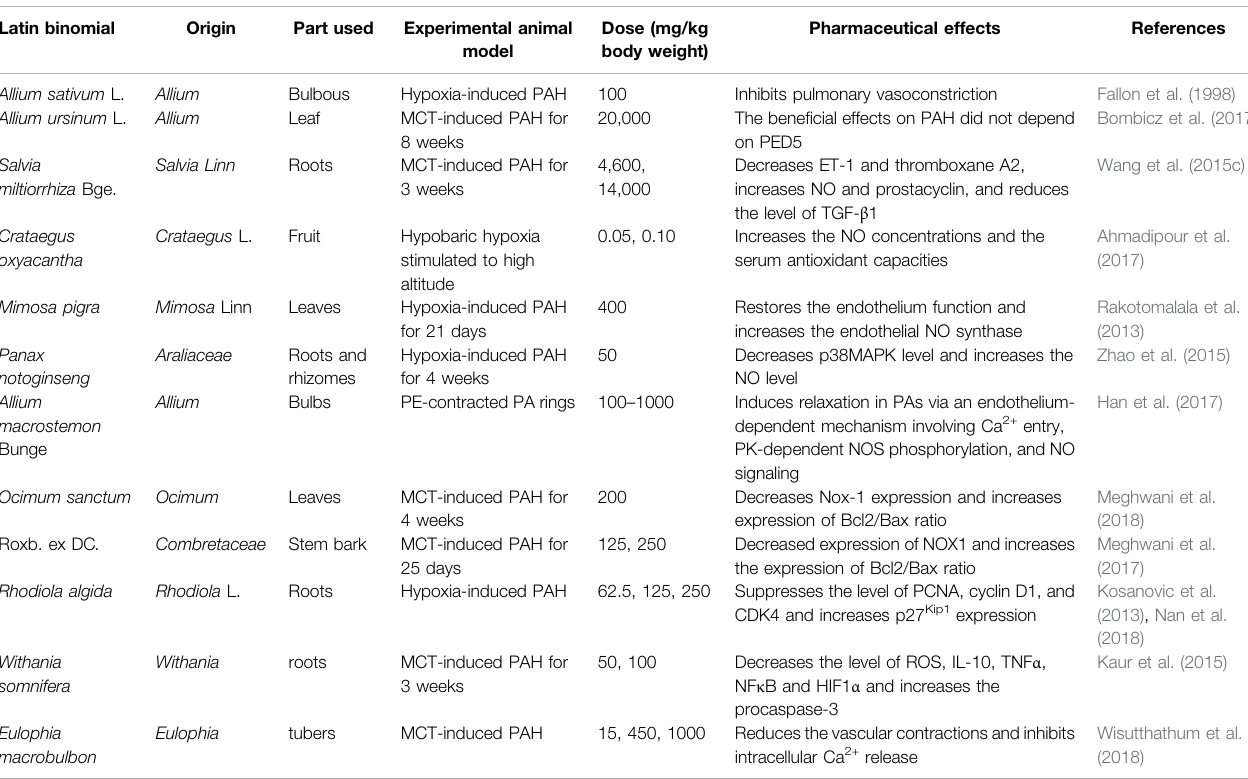
TABLE 2 | Single THM in the PAH